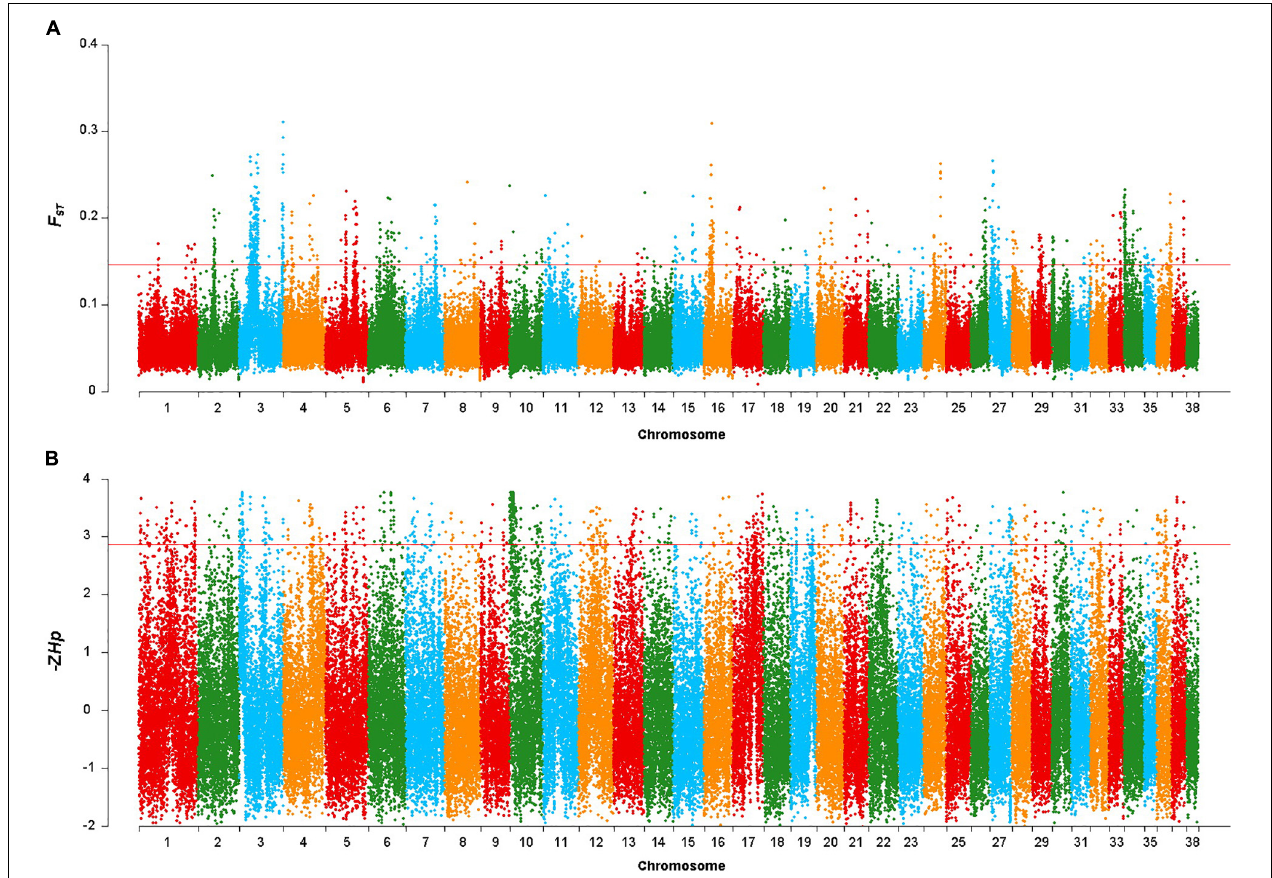
FIGURE 2 | Genomic regions with signatures of selective sweeps identified using 25-kb non-overlapping windowed Fst and Hp approaches. (A) Plot of the Fst values in the Shiba Inu vs. Mame Shiba Inu. Red line indicates the significance threshold of the top 1% (Fst = 0.146). (B) Plot of the –ZHp values of Mame Shiba Inu. Red line indicates the significance threshold of the top 1% (–ZHp =